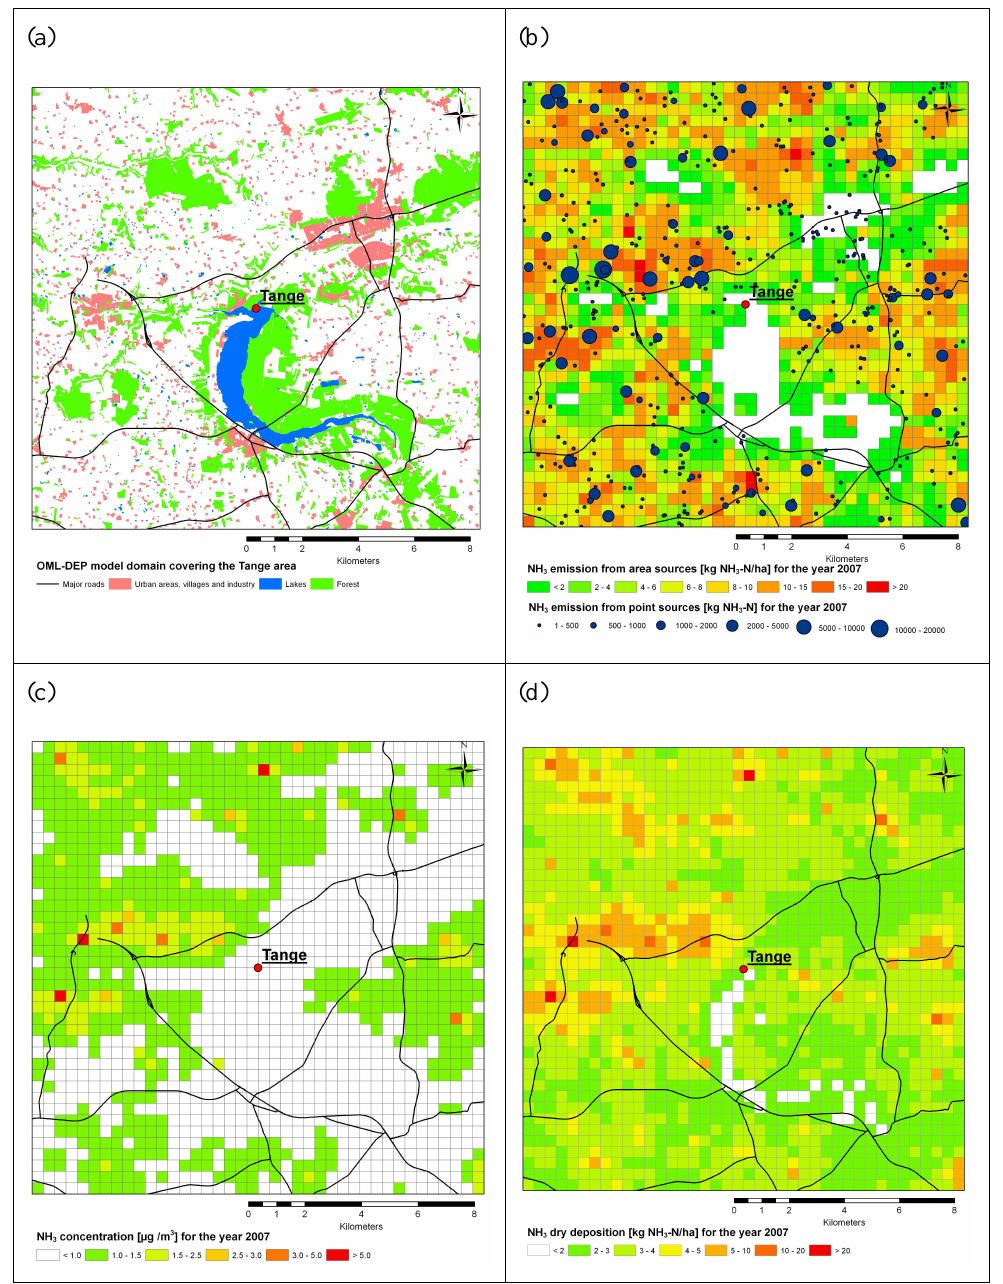
Fig. 2. (a) The OML-DEP 16km × 16km model domain centered around the Tange site. The resolution in the local-scale model is 400m × 400m. (b) The applied NH 3 emissions divided into area and point sources for the year 2007. (c) The yearly averaged NH 3 con- centration as calculated by the DAMOS system for the year 2007. (d) The yearly total dry deposition of NH 3 as calculated by the DAMOS system for the year